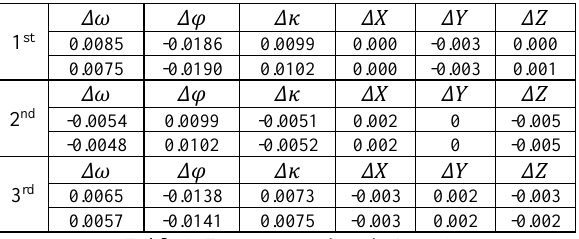
Table 1. Error comparison in Case 1.